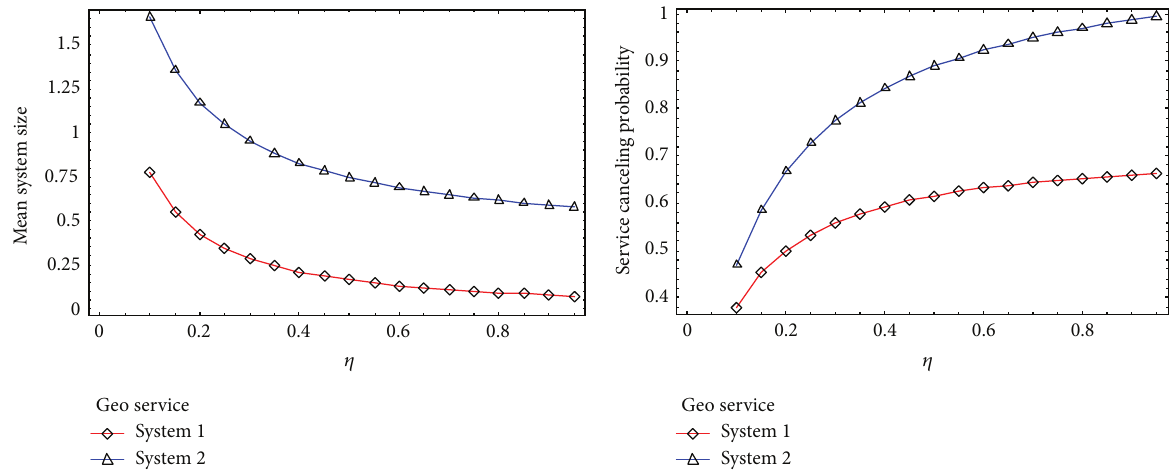
Figure 1: Mean system size and service canceling probability over 𝜂 with geometric service time distribution.